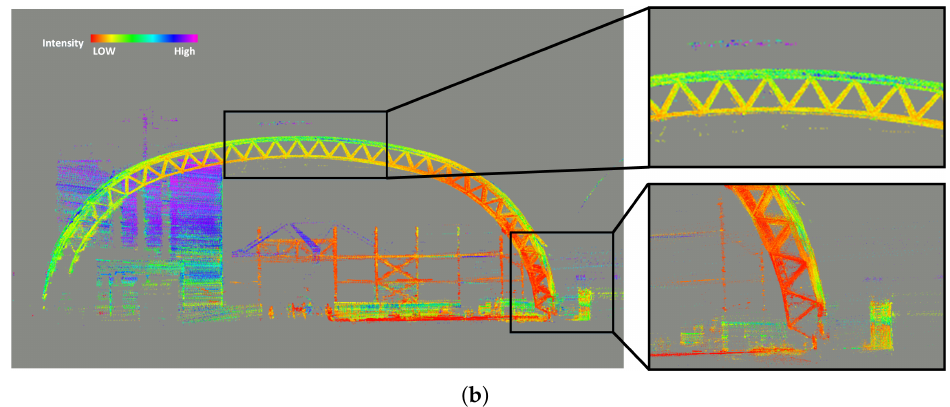
Figure 13. The side view of the point cloud map. ( a , b ) are the top views of the point cloud maps built by LIO-SAM and the proposed navigation system,